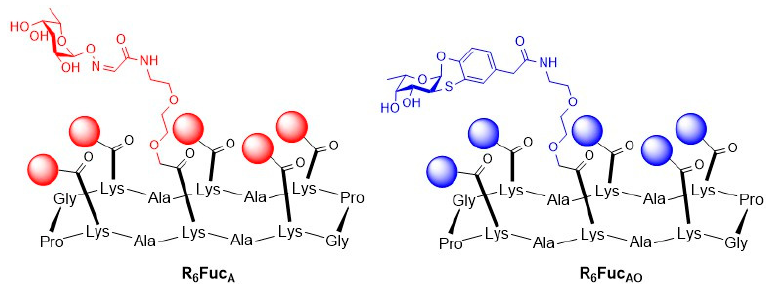
Figure 9. Structure of the hexavalent glycoconjugates carrying aminooxylated fucose or aryl fucose ligands,